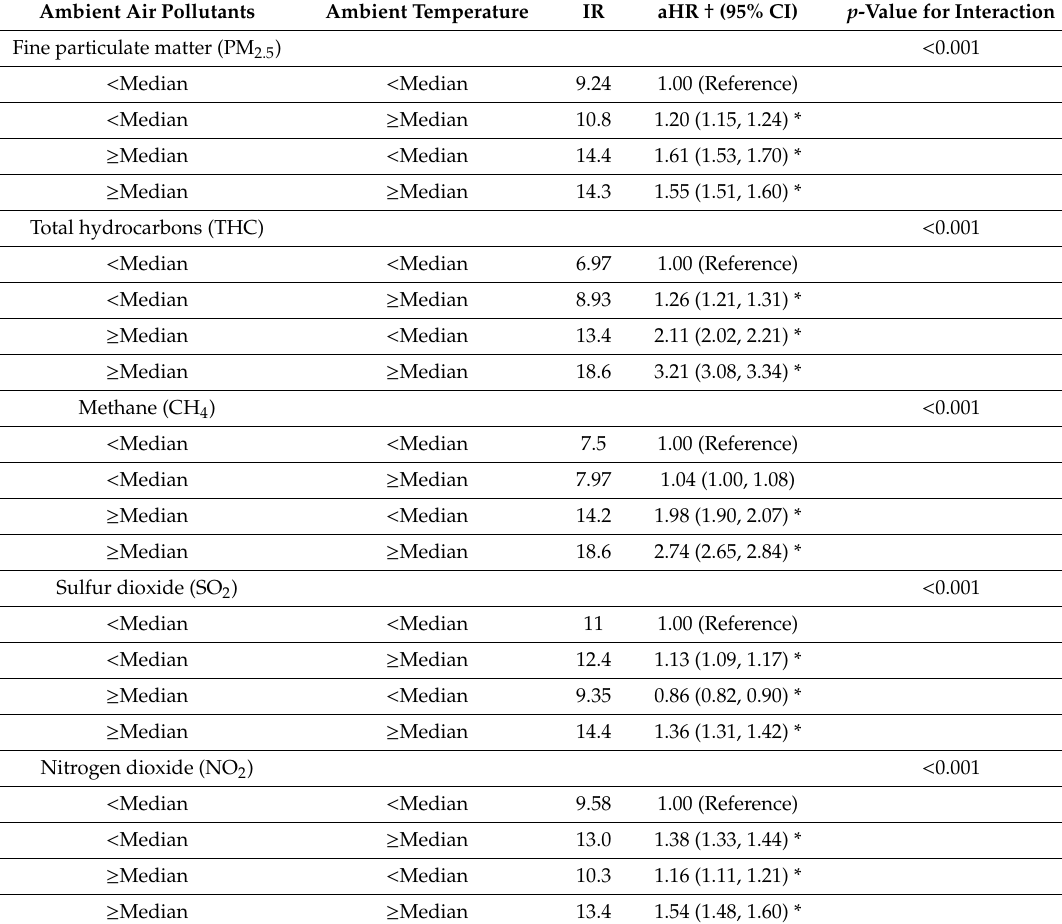
Table 4. Association between ambient temperature with interaction of ambient air pollutants and risks for recurrent headaches by Cox proportional hazard regression analysis.